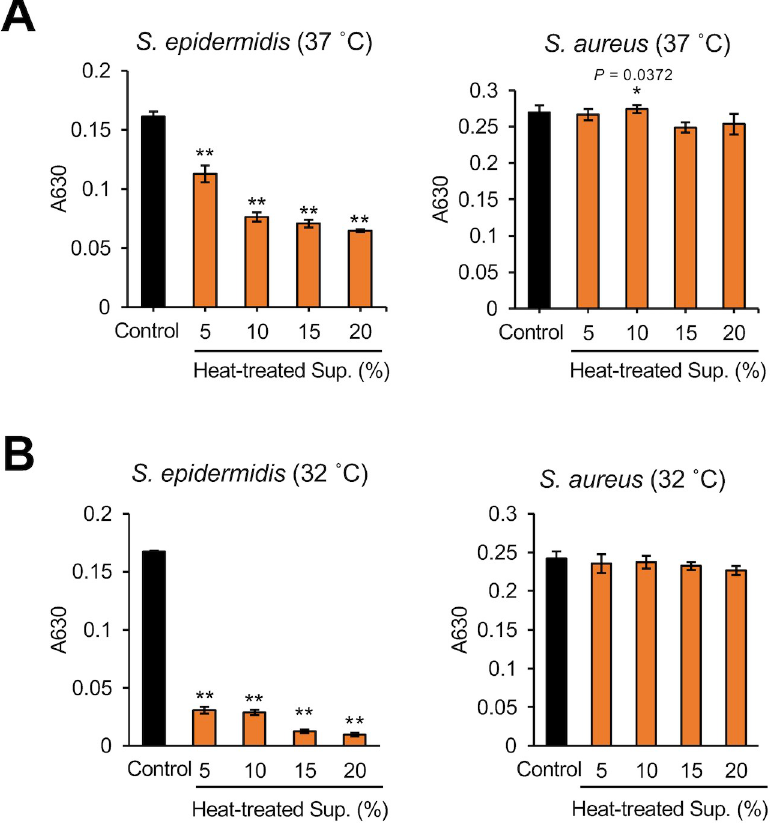
Fig 2. Dose dependency of the inhibitory effect of heat-treated culture supernatant of D . acidovorans against S . epidermidis growth. S . epidermidis (1 × 10 4 cells/mL) and S . aureus (1 × 10 4 cells/mL) in NB were mixed with 5% to 20% D . acidovorans heat-treated CS (Heat-treated CS). After incubating at 37˚C for 12 h (A) or 32˚C for 18 h (B), absorbance at 630 nm was measured using a microplate reader. Error bars indicate the SD of the means (n = 3). Statistical differences between groups were analyzed by the Williams test. ( � : P < 0.05, �� : P < 0.001).